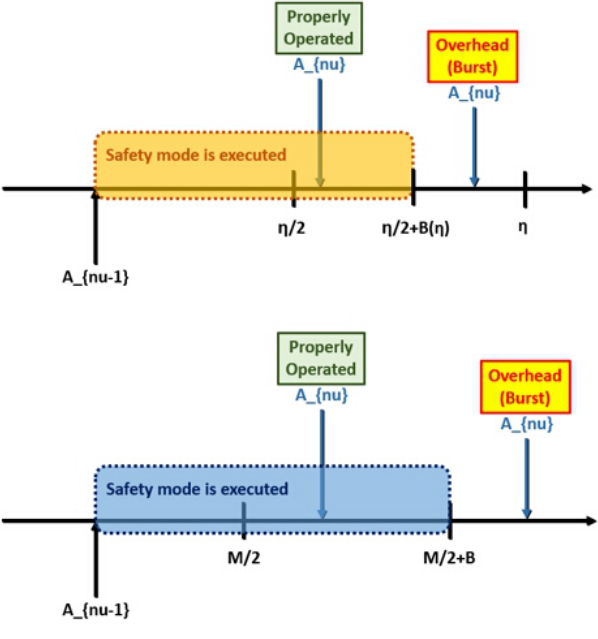
Figure 4. Operation of the safety mode of layer 0 ( top ) and layer 1 ( bottom